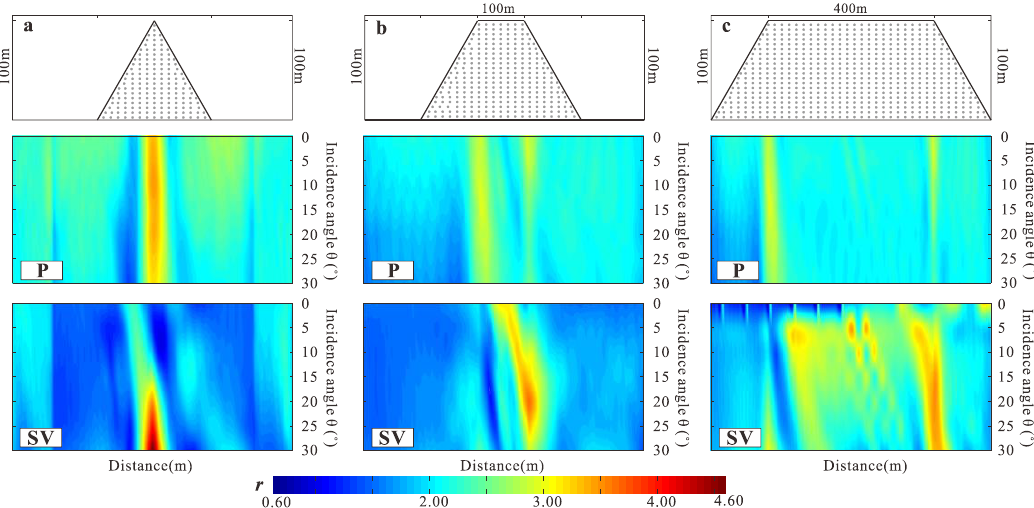
Figure 14. Variations of the seismic responses along the slope ridges of the real amplification ratio ( r ) of PGA with varied angles of wave incidence at P waves and SV waves. ( a ) slope width of 0 m, ( b ) slope width of 100 m, ( c ) slope width of 400 m.